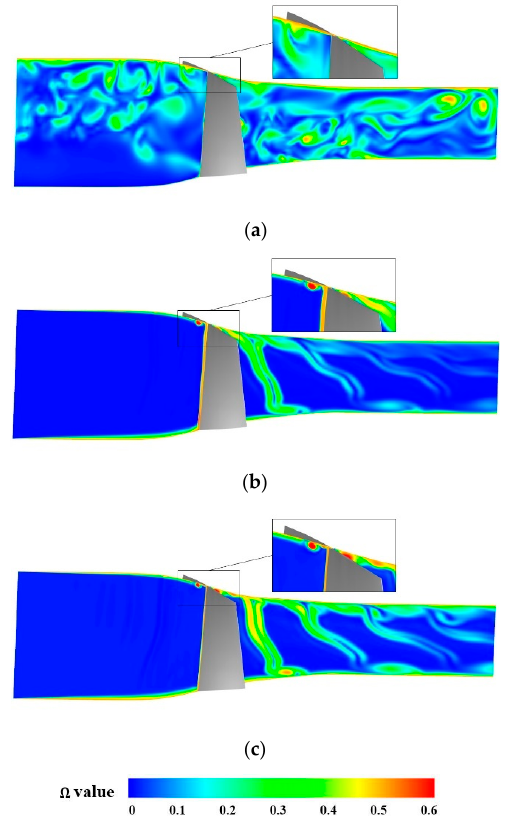
Figure 9. Contour of Ω value of the NASA rotor 37 at ( a ) NS condition, ( b ) design condition, ( c ) NC condition.